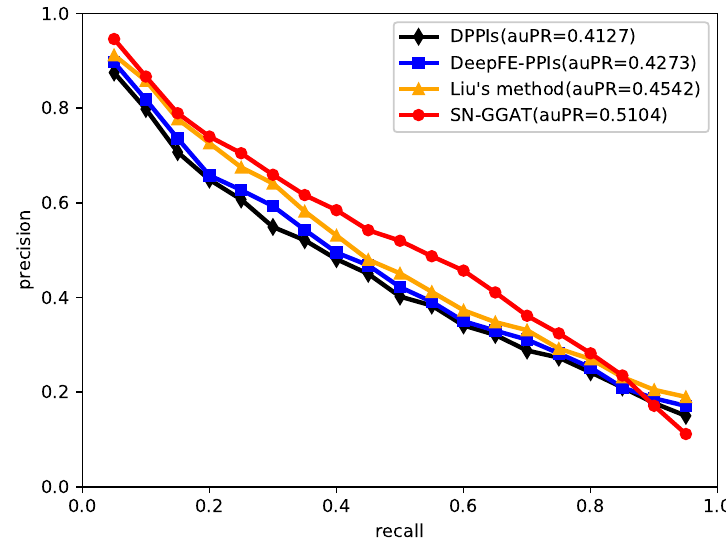
Figure 10. Performance comparison of SN-GGAT with other state-of-the-art methods on the Human dataset. The auPR is the mean of 10-fold cross validation.